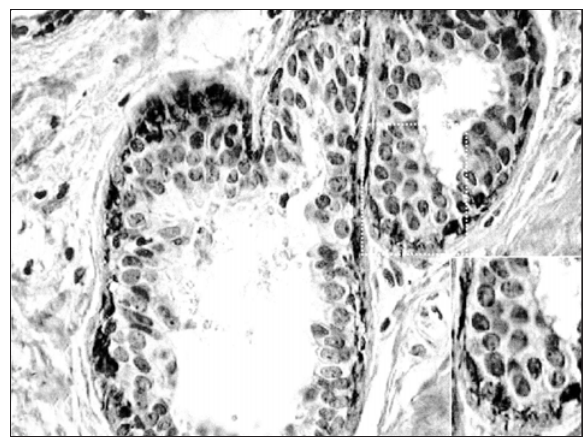
Figura 1 – Padrão de expressão membranar da P-caderina no tecido mamário normal (células mioepiteliais) (400x)